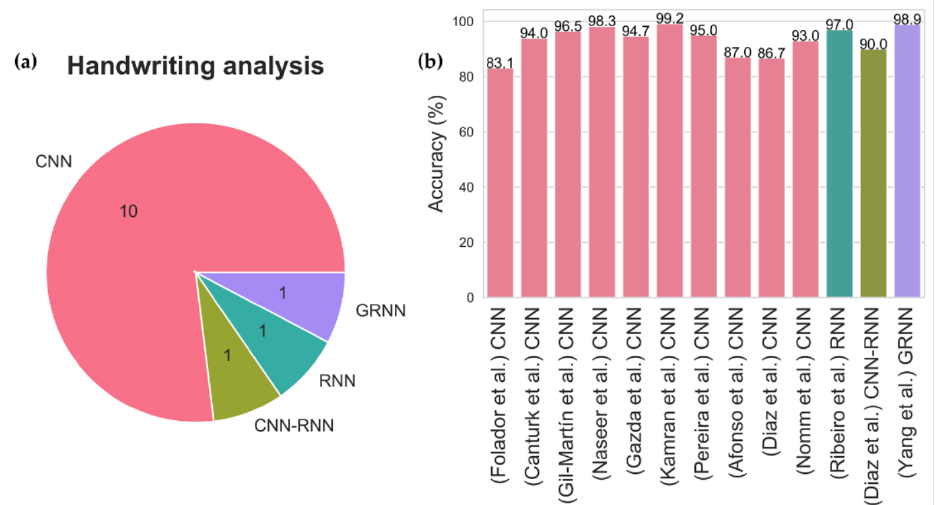
Figure 10. ( a ) Pie chart representation of various deep learning models proposed for handwrit- ing analysis and, ( b ) Bar chart representation of model accuracy for each deep learning study in handwriting